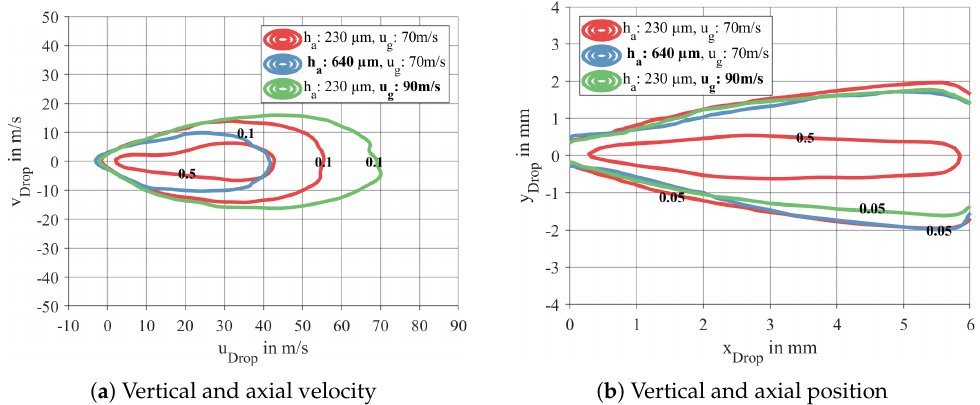
Figure 17. Effect of gas velocity and prefilmer geometry on the interdependencies of the spray quantities for p g =